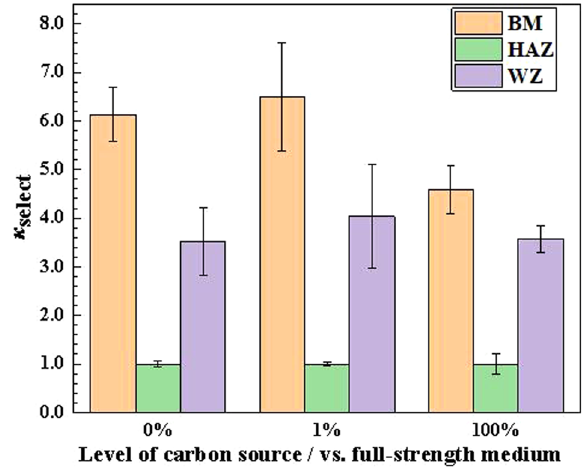
Fig. 10 κ select of SRB corrosion for welded joints. The fi gure shows κ select of SRB corrosion of the welded joints in the mediums with different organic carbon source starvation (error bars stand for the standard deviations from three independent